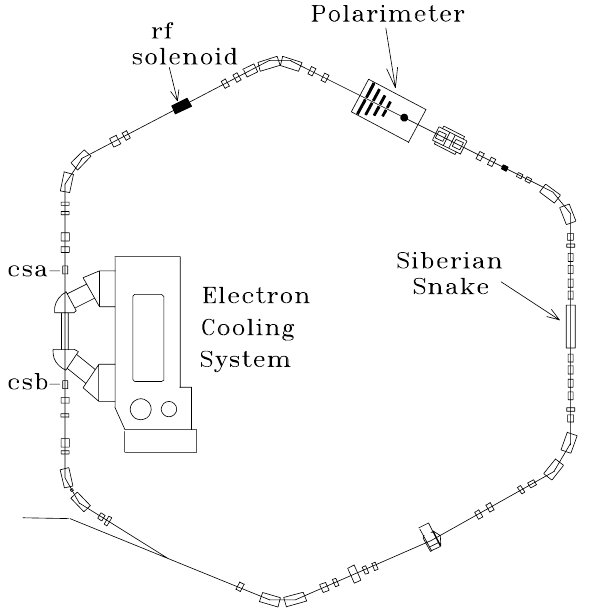
FIG. 1. Layout of the IUCF Cooler Ring with the rf solenoid, the Siberian snake, and the polarimeter. precision in resetting the solenoid’s current was at best 0.01%. Even this very small variation, which slightly shifted the snake’s strength, significantly changed the rf resonance’s frequency. Therefore, for the two later data sets, each data point was shifted by 1 (cid:53)(cid:48)(cid:48) or 2 (cid:50)(cid:48)(cid:48) Hz in Fig. 2 to correct for the shift in the snake current; the horizontal bars on these data points show these two cor- rections to the measured frequencies [20].